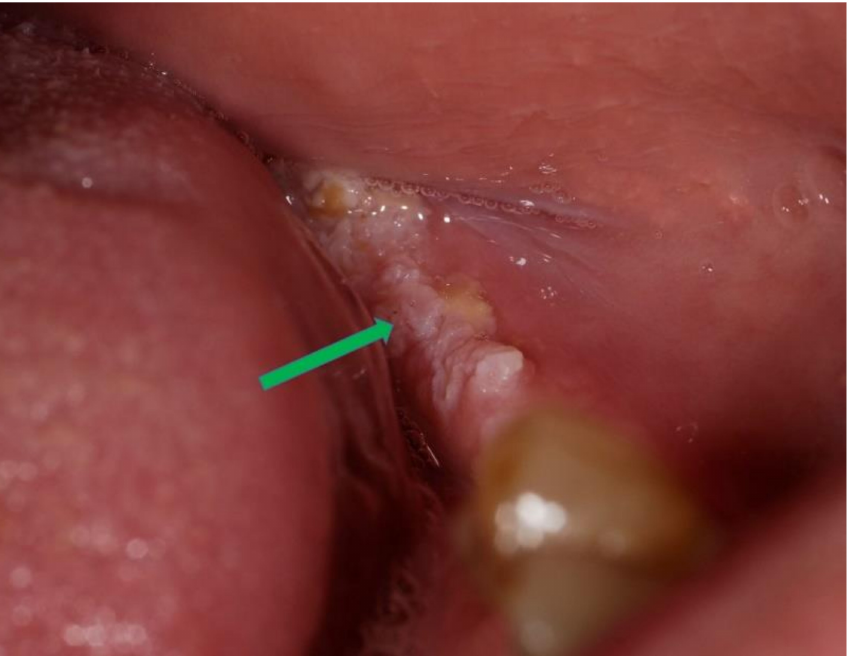
Figure 2. Oral warty dyskeratoma exhibiting a verrucous/warty/pebbly surface (blue